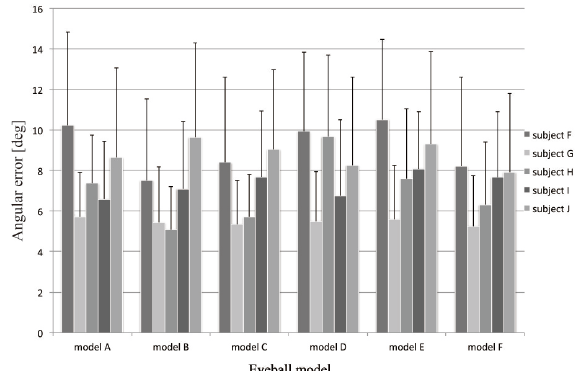
Figure 19 . Comparison of results obtained using different anatomically-based